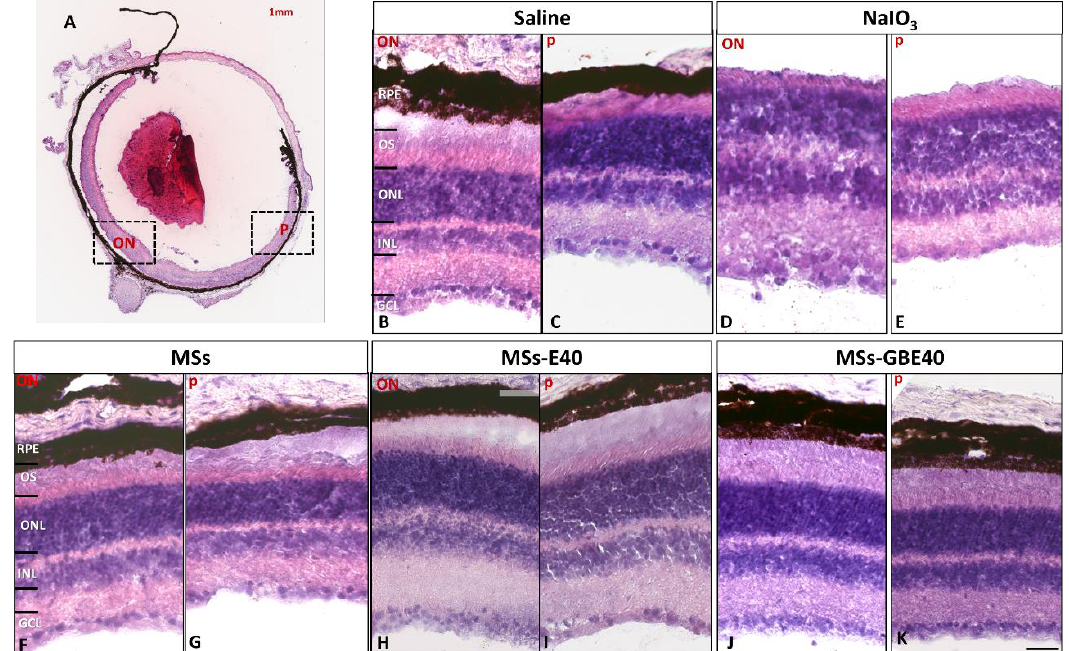
Figure 6. Histology (hematoxylin and eosin staining) of retinas one week after intravitreal injection. ( A ) Whole eye section showing an optic nerve (ON) and peripheral (p) framed areas observed. Retinal section from eye injected with saline ( B , C ), sodium iodate ( D , E ), MSs ( F , G ), MSs-E40 ( H , I ), MSs-GBE40 ( J , K ). No alterations (swelling, vacuoles, missed cells) were observed in any studied group. Scale bar: 1 mm ( A ) and 100 µm ( B – I ). Blank MSs (MSs); MSs/VitaminE(40) (MSs-E40), GDNF/BDNF/VitE(40)-loaded PLGA microspheres (MSs-GBE40). Abbreviations: RPE: retinal pigment epithelium, OS: outer segments, ONL: outer nuclear layer, INL: inner nuclear layer, GCL: ganglion cell layer, ON: optic nerve, p: periphery.